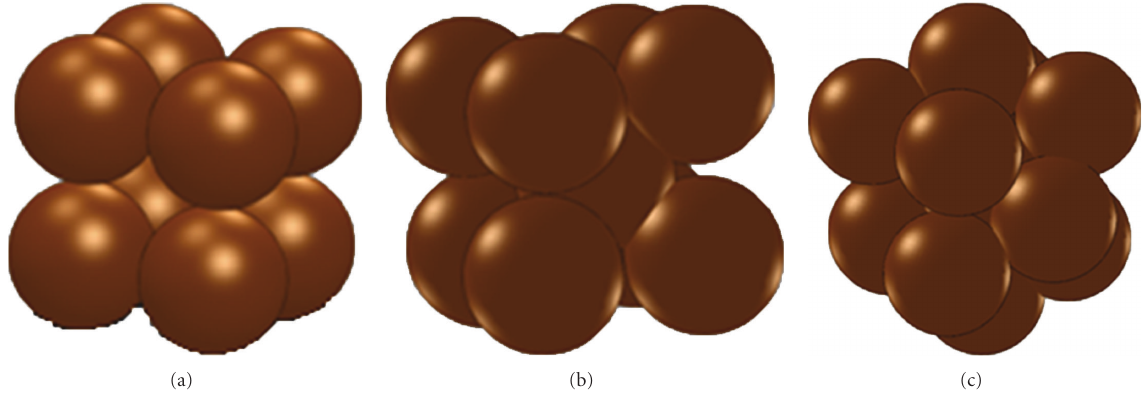
Figure 6: Arrangements of the silica gel particles for CFD simulation.